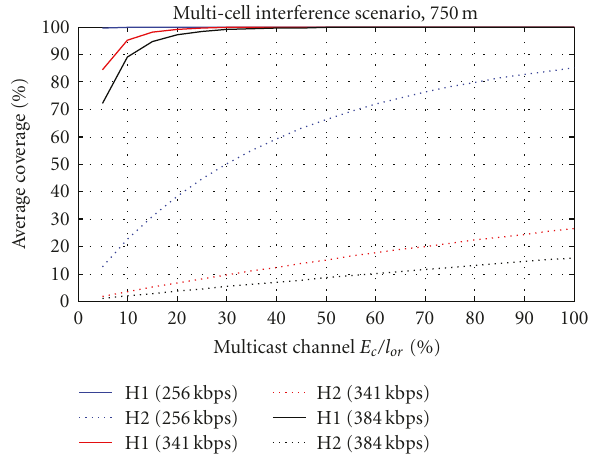
Figure 15: Average coverage (%) versus E c /I or , 2 Radio Links, k = 0 . 1.